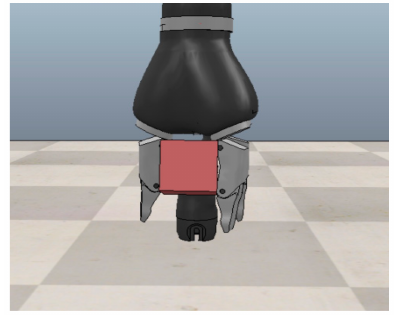
Figure 2. An example of robotic manipulation